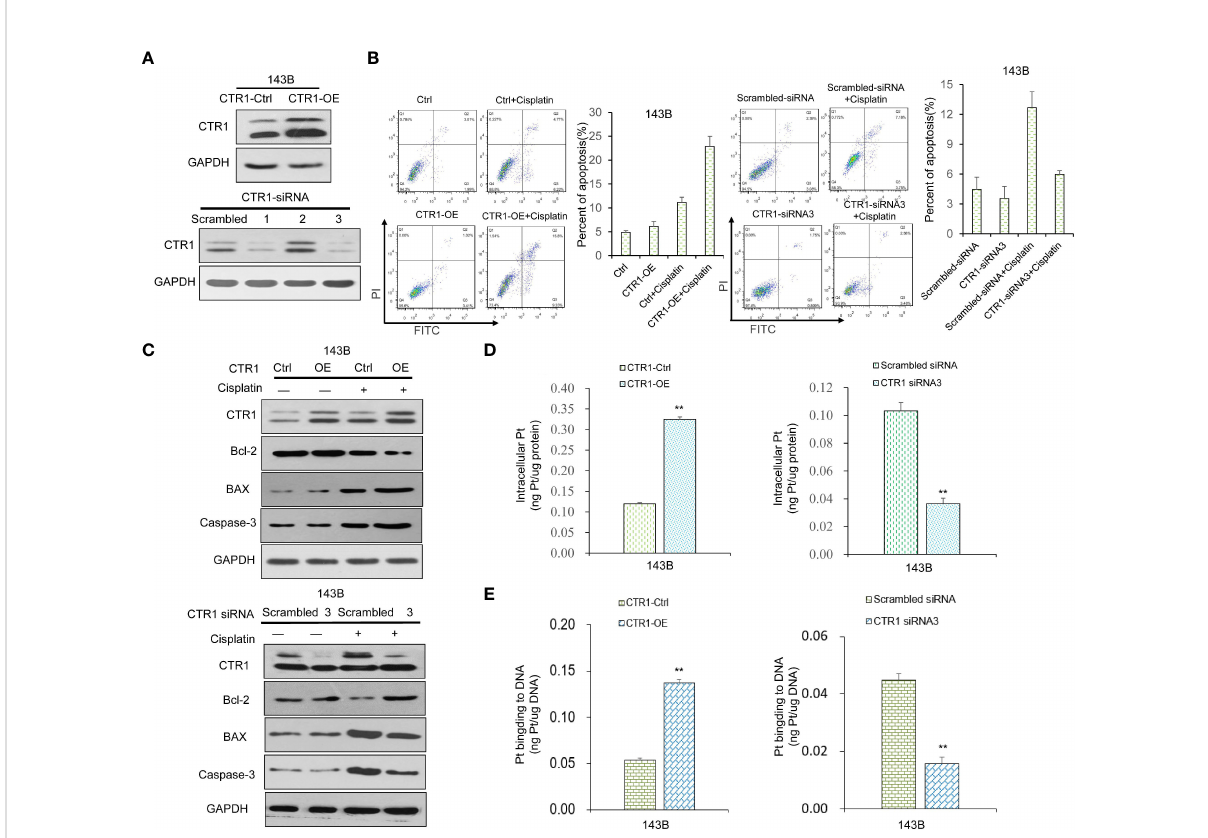
FIGURE 2 The function of CTR1 on apoptosis and cisplatin uptake in OS cells. (A) The 143B cell line was transfected with CTR1-overexpression (CTR1-OE) plasmid or indicated siRNAs to produce CTR1-OE or CTR1- knockdown (CTR1-KD) cells, respectively. The expression of CTR1 was examined by western blot. GAPDH was used as the internal control. (B) Cell apoptosis rate was measured in different CTR1-expressing 143B OS cell line with or without cisplatin incubation. Data are representative of three independent experiments. (C) The expression of apoptosis marker proteins in different CTR1-expressing 143B OS cell lines with or without cisplatin incubation was determined by western blot. GAPDH was used as the internal control. (D) Cisplatin accumulation and (E) content of Pt ‐ DNA adducts in CTR1-OE and CTR1-KD 143B cells treated with cisplatin (10 m g/ml) for 24h was detected by ICP-MS. Bars show mean ± SD. Ctrl, the control group; **p <